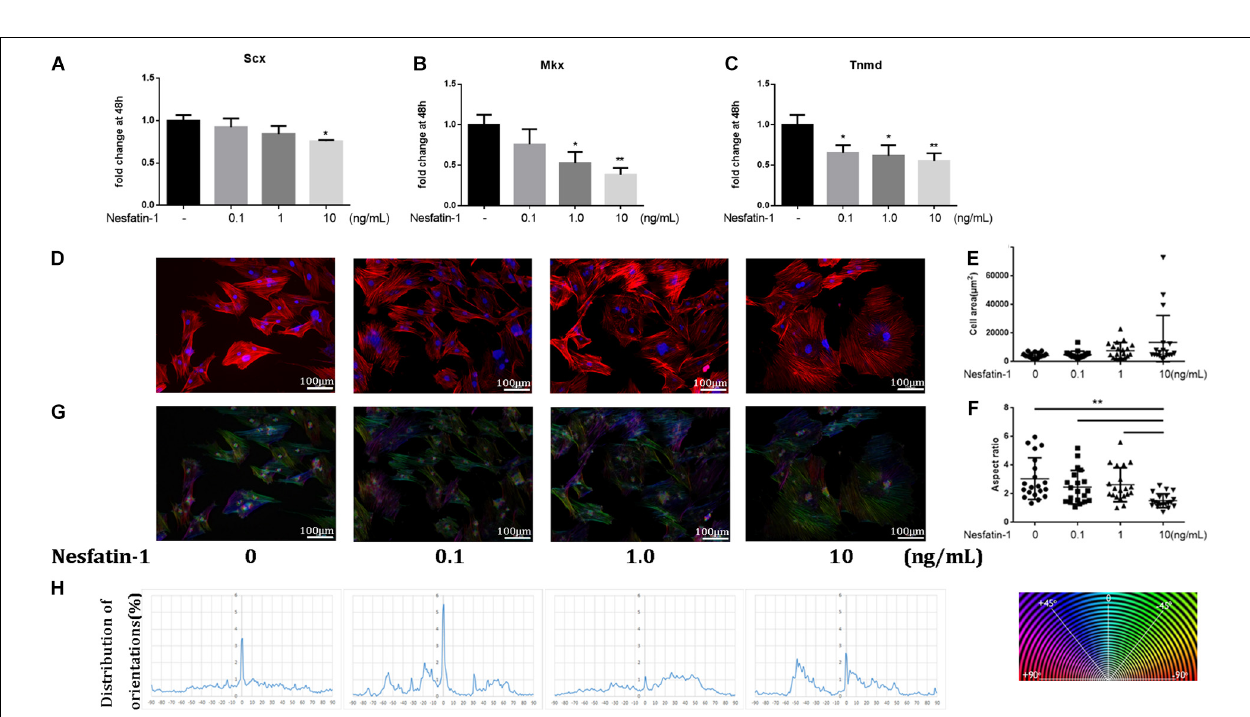
Frontiers in Cell and Developmental Biology |